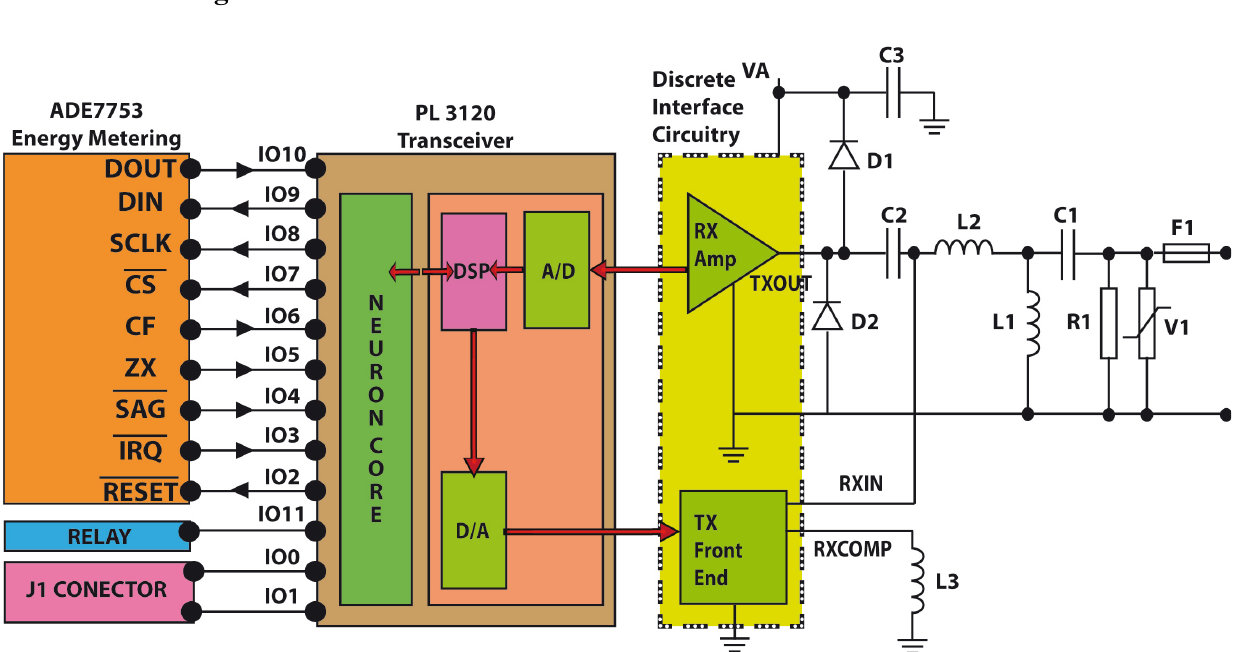
Figure 5. A schematic detail of the PL-3120 and ADE7753